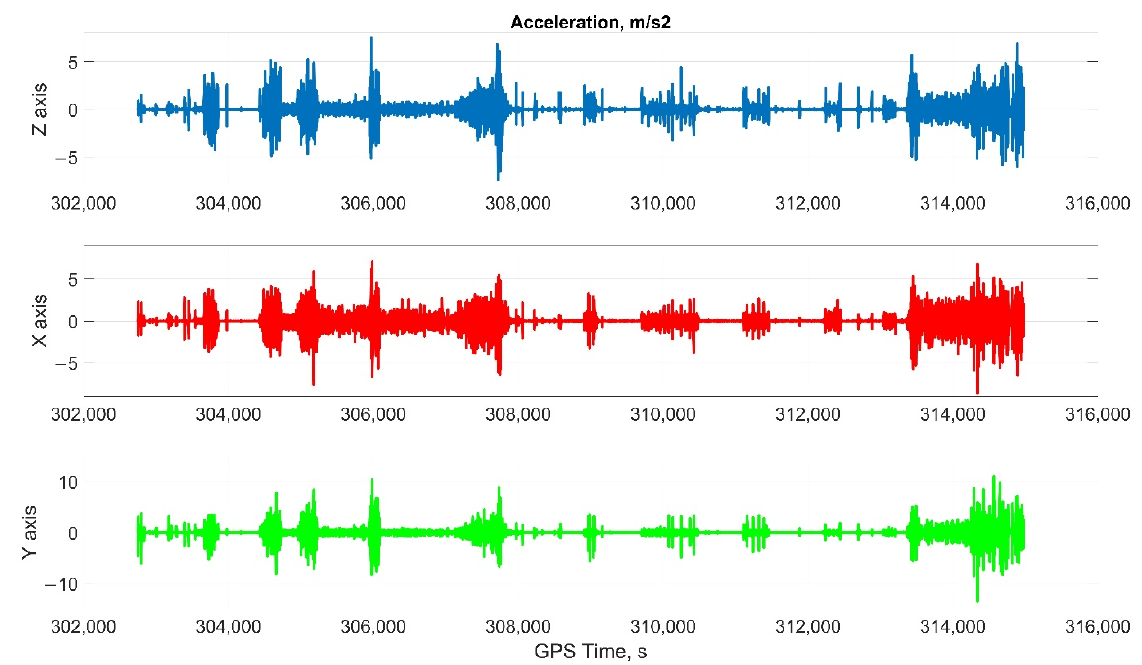
Figure 9. Accelerations in projections onto the body frame in car test (X, lateral axis; Y, longitudinal axis; and Z, completes the right-handed system, up axis when OXY is horizontal plane).